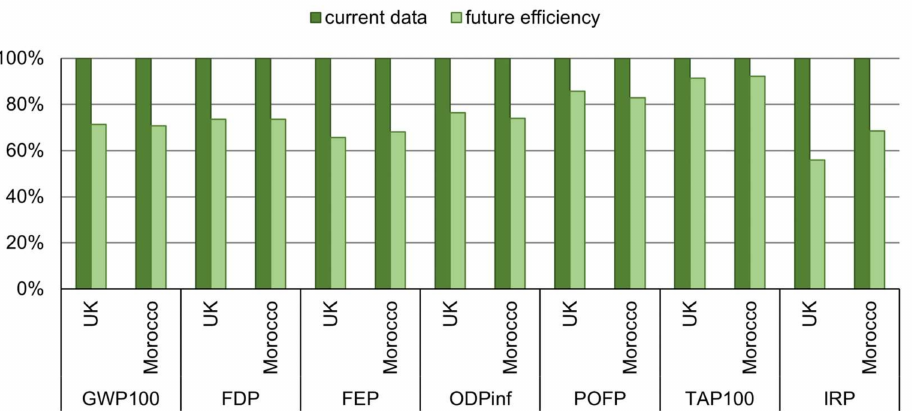
Figure 8. Environmental profile of electricity production based on green ammonia. For the production of green ammonia, current data consider an energy input of 9.5 MWh per t NH 3 ; for the future 6.5 MWh per t NH 3 is considered.